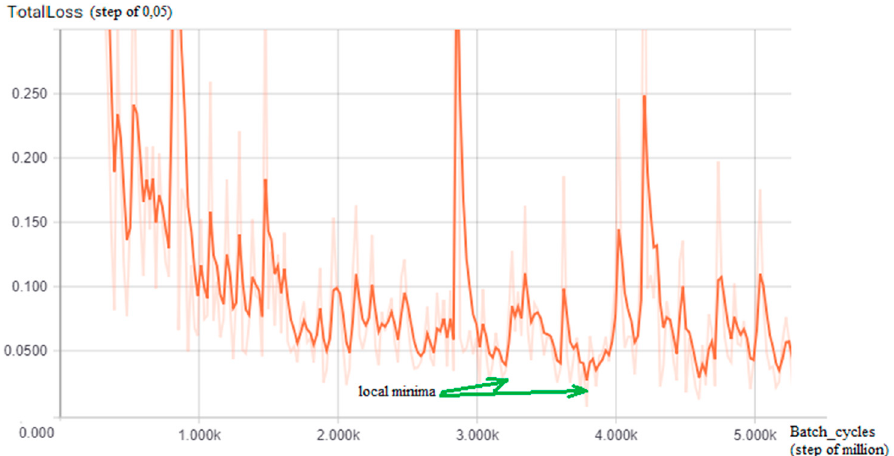
Figure 5. The TensorBoard graph of the loss function (y-axis, step of 0,05) on a subset of the training dataset for the road sign detector: Interesting local minima for the number of training batch cycles results in approximately 3,200,000 and 3,800,000 (green arrows, x-axis = batch size cycle amount, step of million).